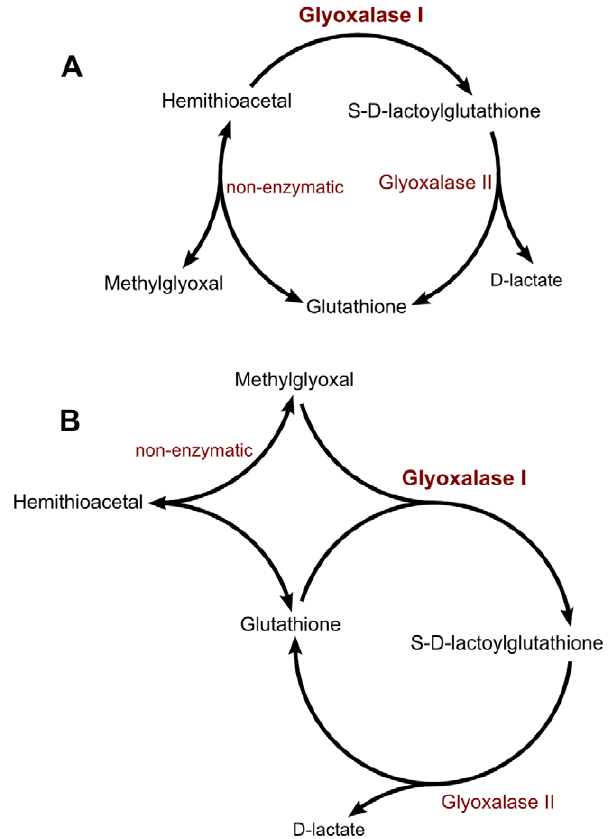
Figure 2. Kinetic models of the glyoxalase pathway. In model 1 (A), glutathione (GSH) and methylglyoxal (MGO) form a hemithioacetal (HTA) which is the substrate of glyoxalase I. In model 2 (B), glutathione and methylglyoxal are sequential substrates of glyoxalase I and the hemithioacetal is formed at the active centre of the enzyme. Glyoxalase II is a one-substrate-one-product irreversible Michaelis Menten enzyme, catalyzing the hydrolysis of S -D-lactoylglutatione (SDLGS) into D-lactate (D-Lac) and glutathione. The rate laws assumed in the models are expressed in equations 15 to 18.